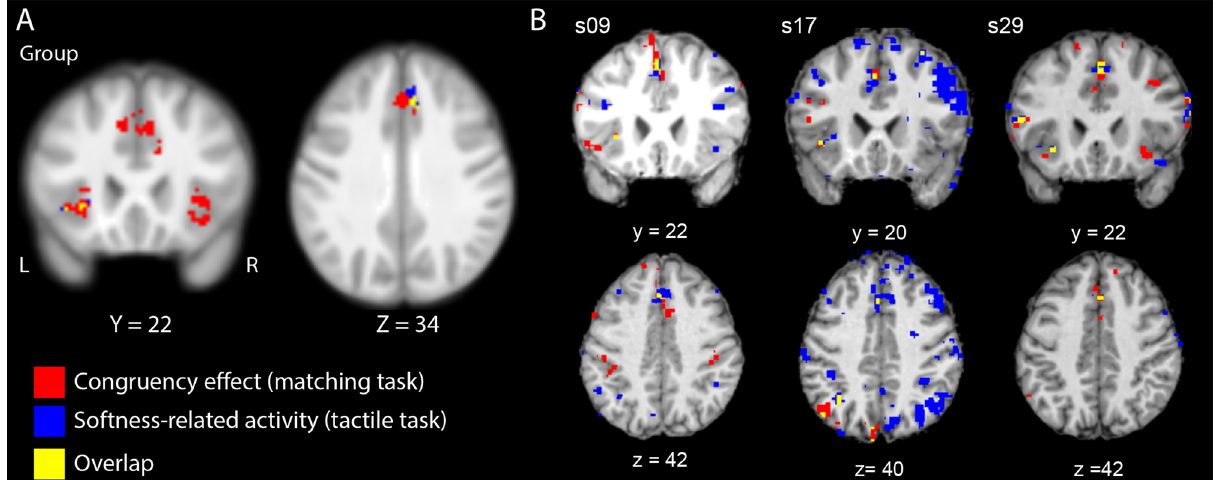
Figure 4. Overlap between the congruency effect in the matching task and the softness-related activation in the tactile task. ( A ) Overlap of activation at the group-level between the congruency effect in the matching task (Fig. 2) and the softness-related activation revealed by the parametric-modulation analysis of the tactile task. The activation was presented on coronal and horizontal sections of the MRI averaged over the subjects. The statistical threshold for the spatial extent test was set at p < 0.05; family-wise error (FWE) corrected for multiple comparisons over the whole brain when the height (cluster-forming) threshold was set at p < 0.001 (uncorrected). ( B ) Representative individual results of overlapped activation. The height threshold was set at p < 0.001 (uncorrected) without a cluster Tactile task. The contrast for parametric-modulation revealed activation in the left insula, parietal opercu- lum, and medial superior frontal gyrus. As shown in Fig. 4A, the congruency effect in the matching task was overlapped with the softness-related activation in the tactile task in the anterior insula and medial superior frontal gyrus. The conjunction analysis (with conjunction null) using an inclusive masking procedure 33,34 con- firmed significant activation in the left anterior insula and medial superior frontal gyrus (FWE corrected p values < 0.05). Figure 4B shows the data of three representative subjects. Word judgment task. The contrast of judgment of sound symbolic words against baseline revealed multiple regions of significant activation over the whole brain, including the bilateral insula, medial superior frontal gyrus, and pSTS (Supplemental Fig. 1A). The contrast of the interaction between softness impression and famili- arity [(Familiar_Soft–Familiar_Hard) − (Unfamiliar_Soft–Unfamiliar_Hard)] revealed no significant activation in the hypothesized regions; instead it revealed regions of significant activation in the bilateral lingual gyrus, bilateral middle occipital gyrus, bilateral cuneus, and left inferior occipital gyrus. Given the presence of signifi- cant interaction, we evaluated the effect of softness in each level of familiarity. As compared to the hard unfamil- iar word condition, the soft unfamiliar word condition revealed greater activation in the bilateral lingual gyrus, bilateral middle occipital gyrus, bilateral cuneus, and left inferior occipital gyrus (Supplementary Fig. 1B–E, Supplementary Table 5). By contrast, no brain region showed greater activation in the soft familiar word condi- tion than in the hard familiar word condition. Collectively, no significant effect of softness-hardness impressions in the hypothesized regions was observed in the whole brain analysis. VOI analysis. Next, we conducted volume-of-interests (VOI) analysis to examine the activation patterns in the hypothesized regions (insula and the medial parts of the superior frontal gyrus) across the three tasks (Fig. 5). To minimize the selection bias that using the same dataset for selection and selective analysis cause (“double- dipping” problem) 35 , we used two independent data sets. One data set originated from our previous study 28 and was used to localize peak coordinates in these hypothesized regions. Then, we examined activity in these coor- dinates in the other data set that included the tasks in the present study. Matching task. Two-way repeated-measures ANOVA (2 levels of matching × 2 levels of familiarity) on the con- trast estimates (relative to the control) revealed significant main effects of matching, with the congruent condi- tion showing greater contrast estimates than the incongruent condition in both regions [F(1,31) = 6.2, p = 0.019 for the left insula; F(1, 31) = 25.2, p < 0.001 for the superior frontal gyrus]. The same analysis showed significant main effects of familiarity, with unfamiliar conditions showing greater activation than familiar conditions in both regions [F(1,31) = 5.7, p = 0.023 for the insula; F(1, 30) = 11.8, p = 0.002 for the superior frontal gyrus]. None of the ROIs showed a significant interaction effect ( p values > 0.4). Word judgment task. Two-way repeated-measures ANOVA (2 levels of softness × 2 levels of familiarity) on parameter estimates revealed significant main effect of softness with hard words producing greater activity than soft words in the insula [F(1, 30) = 6.3, p = 0.018]; main effects of familiarity with unfamiliar words producing